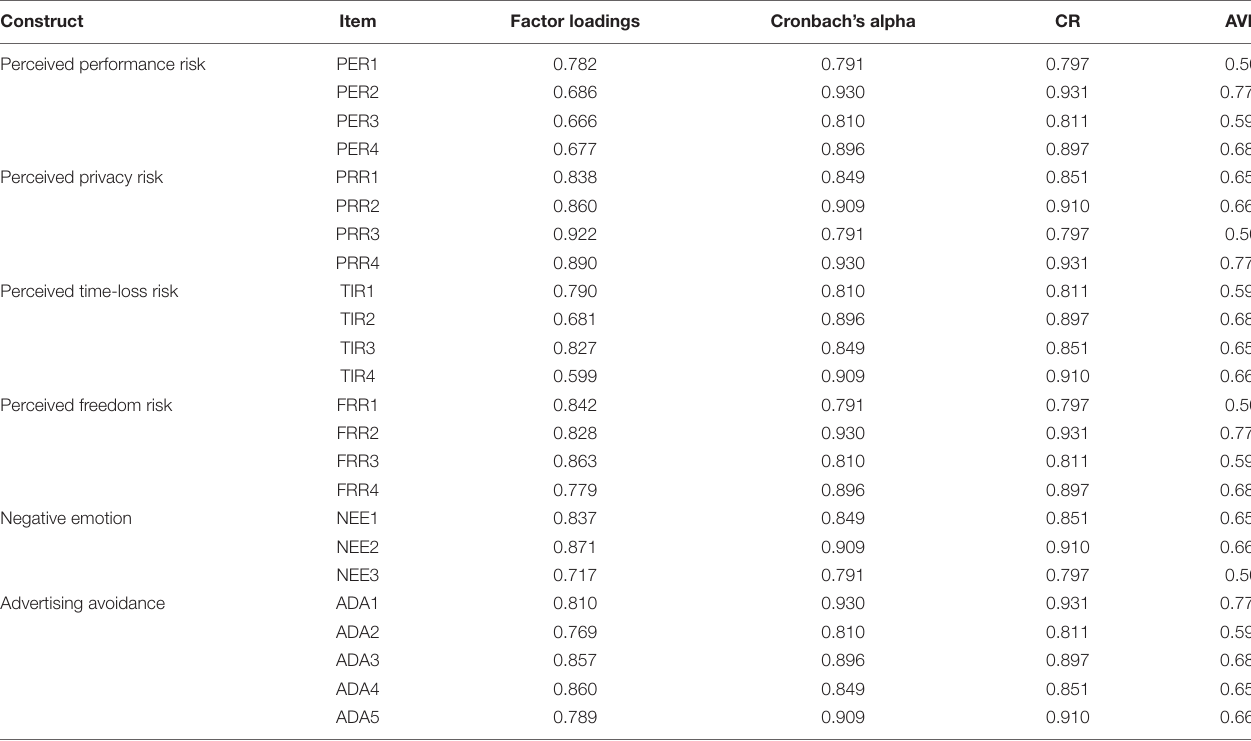
TABLE 4 | Reliability and validity results of measurement